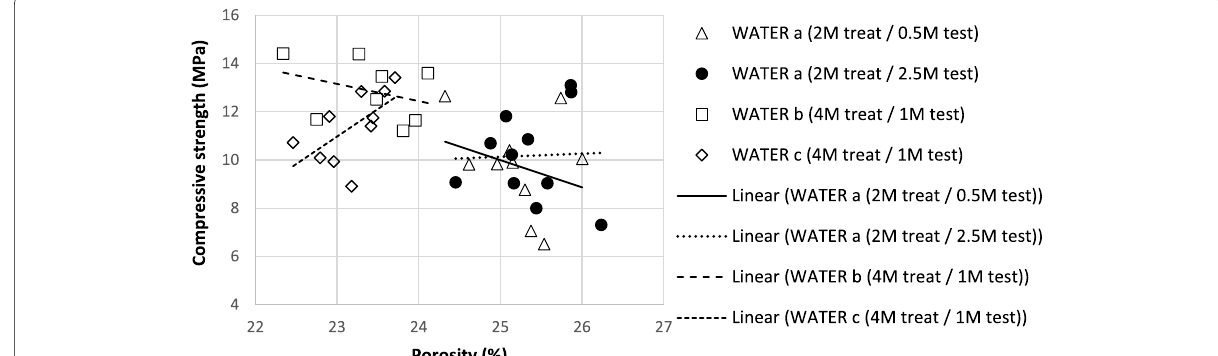
treated X months after casting; “Y M test” =